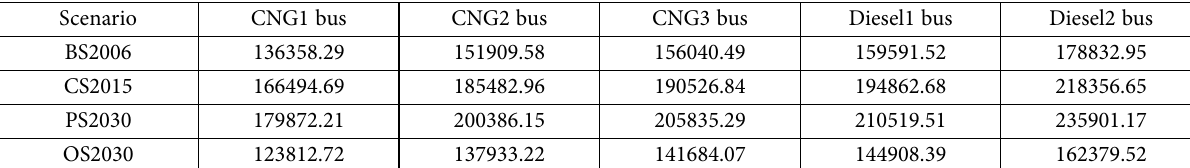
Table 4. Annual CO 2 emissions for the whole road network for different bus concepts according to various scenarios [tonnes/year]